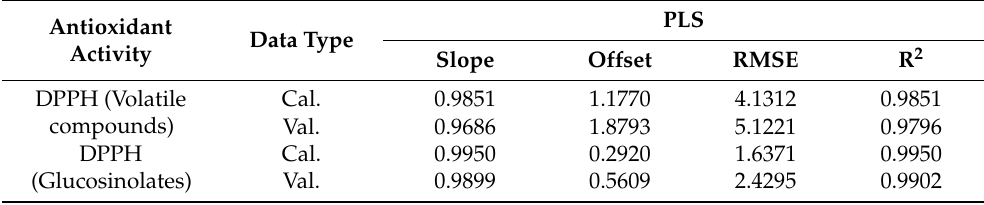
Table 5. The partial least squares regression model parameters used for prediction. Antioxidant